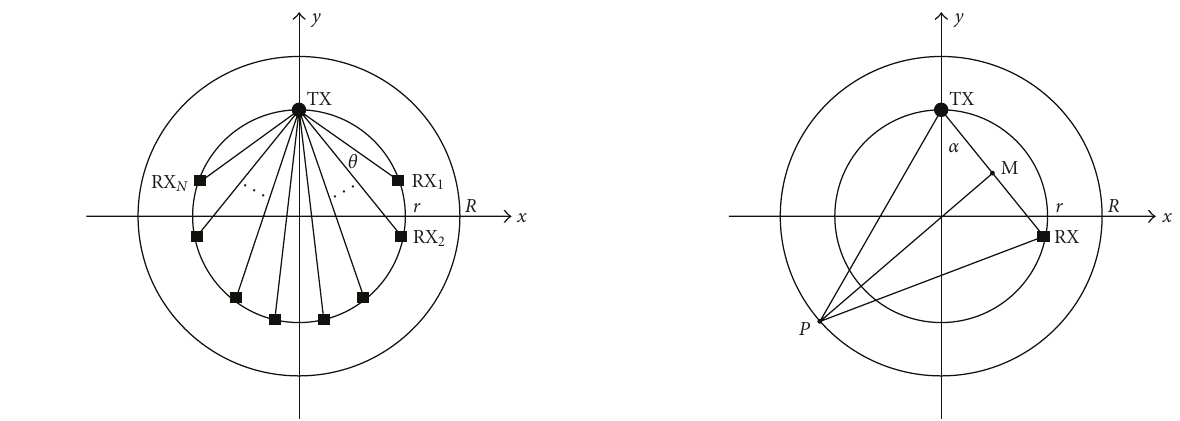
Figure 9: Geometric construction for the computation of ( l 1 · l 2 ) and ( l 1 + l 2 ) for the depicted TX-RX max